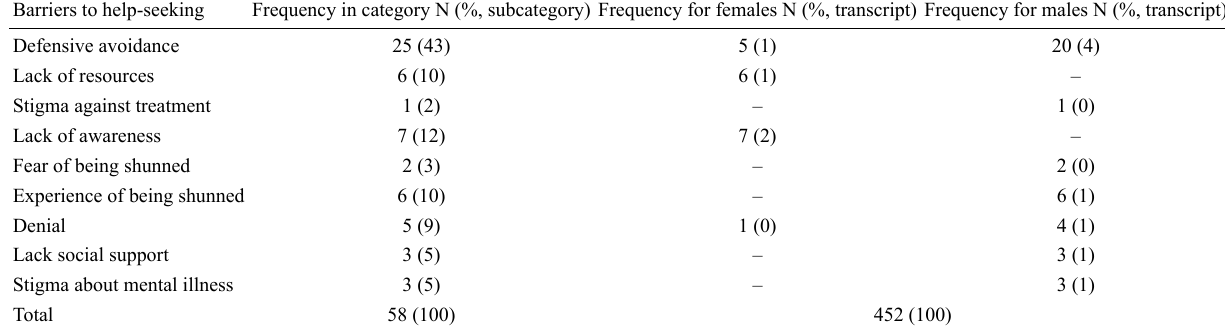
Table 5. Barriers to help-seeking subcategories by